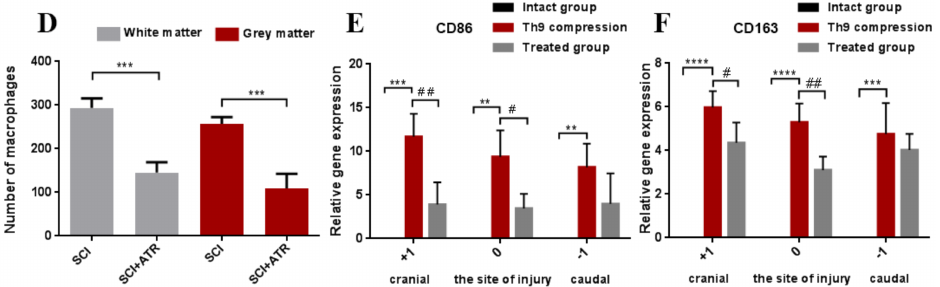
Figure 2. Infiltration of the macrophages in the spinal cord 24 h after a traumatic injury and the treatment with ATR (5 mg/kg; i.p.). Figures from immunohistochemical analysis show no appearance of the macrophages in the intact spinal tissue ( A ), marked macrophage infiltration at the lesion site ( B ) and a strong decrease in macrophage influx after the ATR treatment ( C ). ATR significantly reduced the number of infiltrated macrophages in the grey and white matter ( D ). CD86 mRNA (M1 macrophages) and CD163 mRNA (M2 macrophages) were confirmed by RT-PCR in the whole cranio-caudal extent of the spinal cord ( E , F ). Scale bars: ( A , b , c —1000 µ m; B , C —100 µ m). Data are the mean values of nine experiments (4 IHC, 5 RT-PCR) ± SD. The results from the cell counting were statistically evaluated using a parametric T -Test and the results from the RT-PCR were evaluated with one-way ANOVA; # p < 0.05; ** p < 0.01; ## p < 0.01; *** p < 0.001; **** p < 0.0001. Atorvastatin—ATR; ED-1—macrophages;